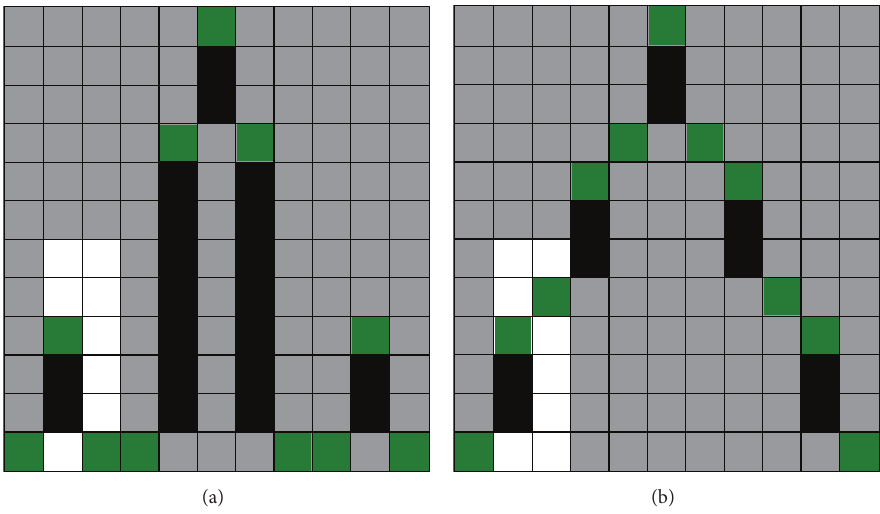
Figure 5: (a) Result after selection of fourth pixel in 𝑎 column; (b) result after selection of fifth pixel in 𝑏 column.